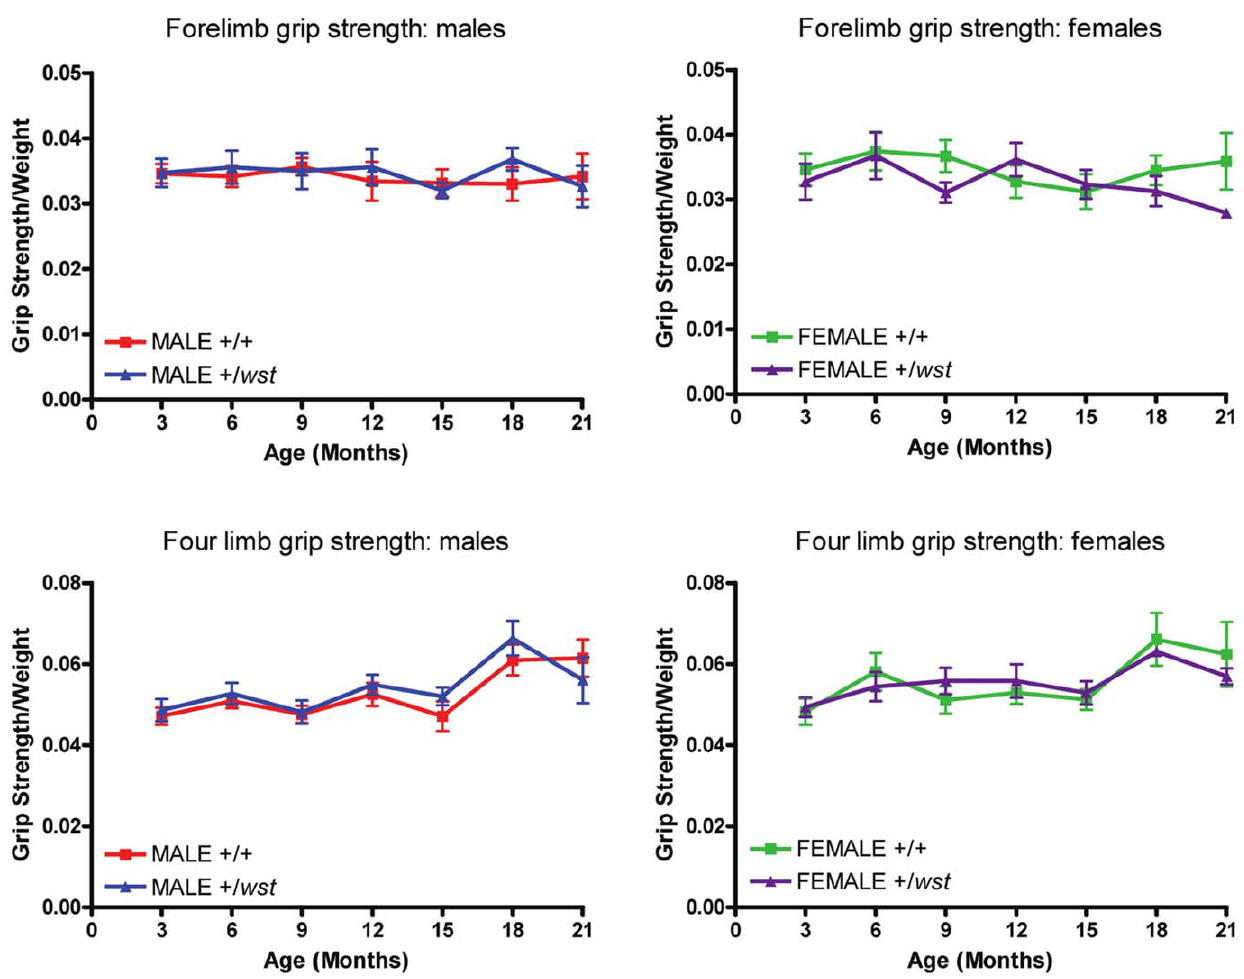
Figure 3. Grip strength analysis of aged mice. Grip strength data for the entire ageing study. Graphs on the left display male data and graphs on the right display female data. Top graphs display forelimb data only and the bottom 2 graphs display data from all four limbs. WT indicates wild- type animals, HET indicates heterozygote animals. Error bars represent the standard error of the mean.